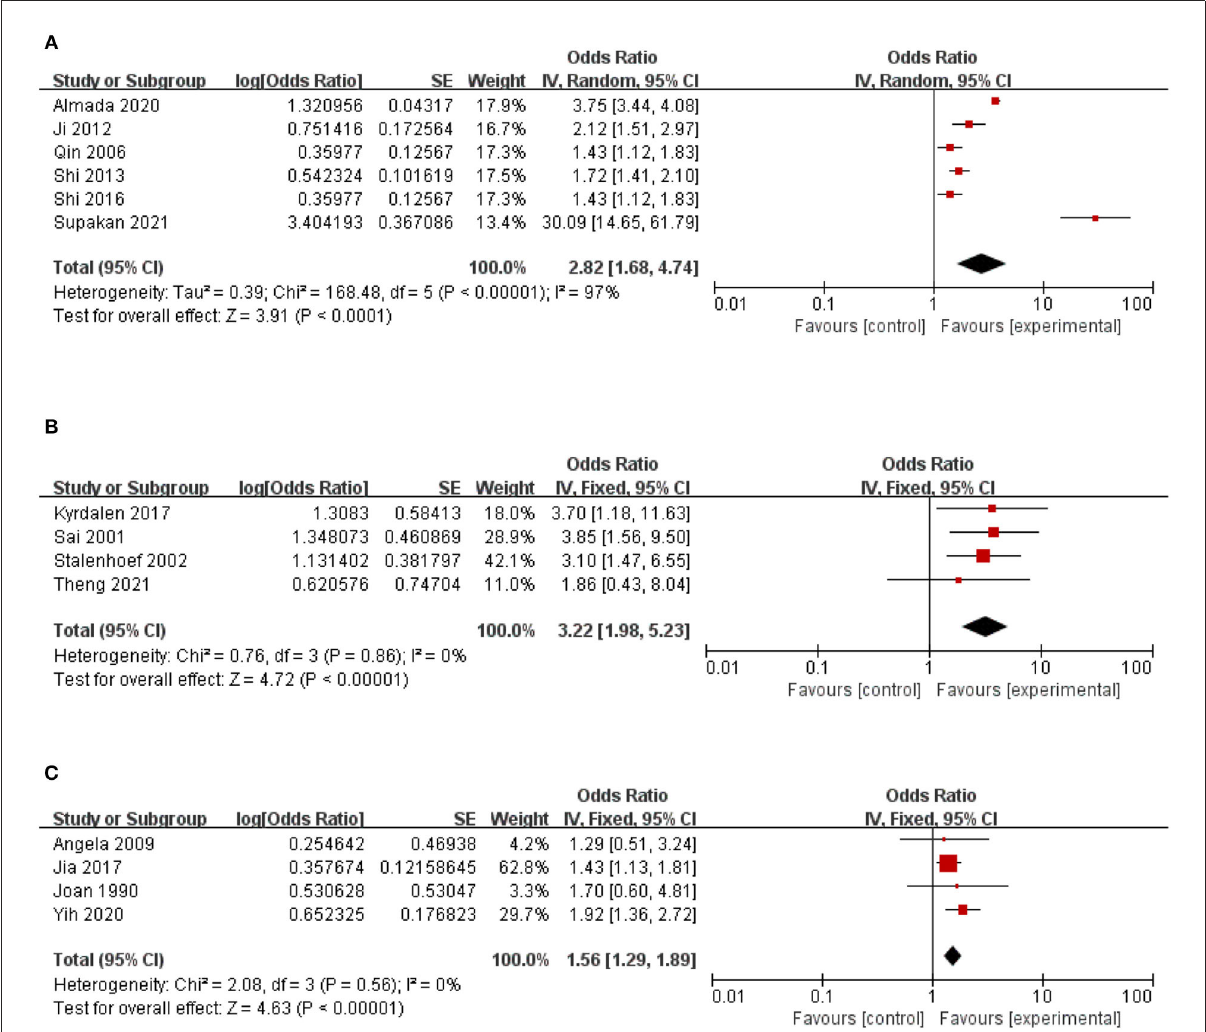
FIGURE3 A forest plot for the association between falls among community-dwelling older adults. (A) Fear of falling. (B) History of falls. (C) Vision